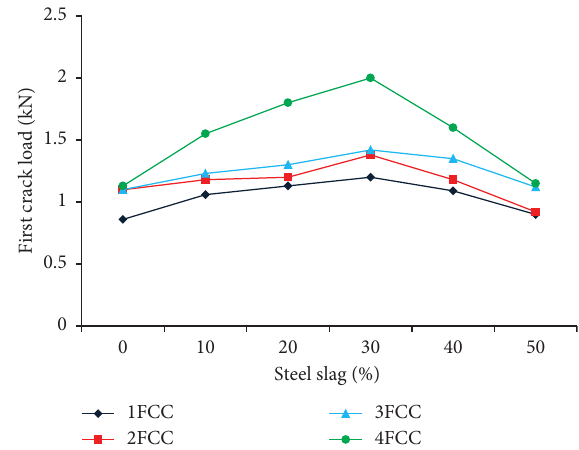
Figure 3: First crack load for different levels of steel slag re- placement and volume fractions of chicken mesh ferrocement laminates.